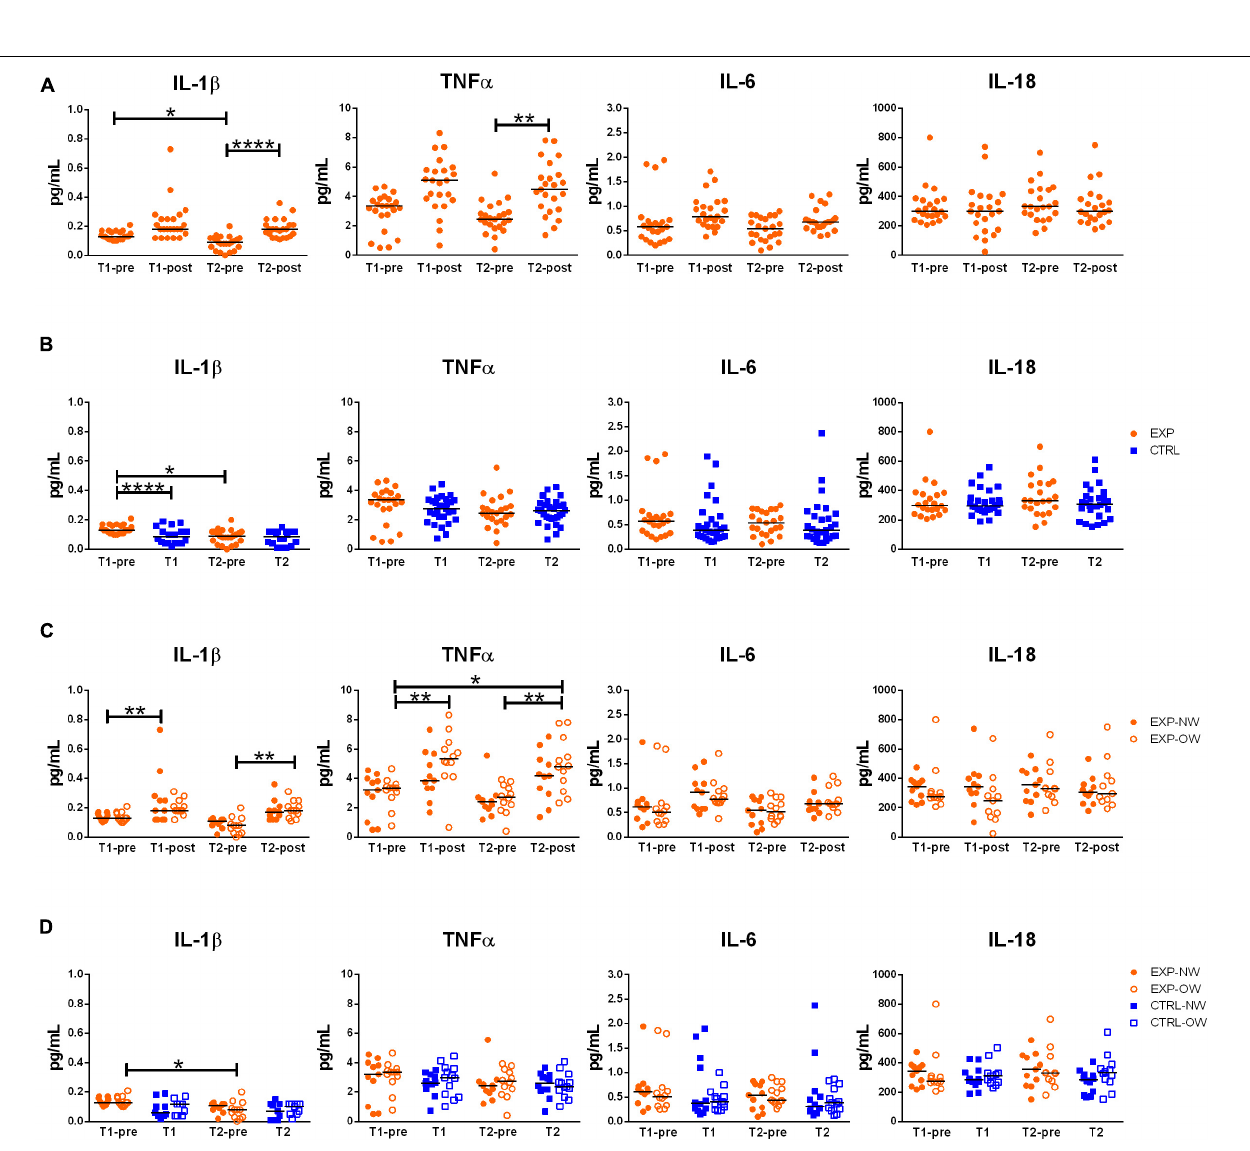
FIGURE 3 | Circulating levels of relevant cytokines associated to inflammasome pathway activation. Concentrations of IL-1 β , TNF α , IL-6 and IL-18 in sera from elderly women underwent to a 12-week aerobic Nordic walking training program (EXP, n = 29) and untrained controls (CTRL, n = 35). (A) Circulating levels of the assayed cytokines in the whole EXP group before and after the first (T1-pre and T1-post) and the last (T2-pre and T2-post) sessions of Nordic walking. (B) Circulating levels of the assayed cytokines in the whole EXP group (orange dots), before the first and the last (T1-pre and T2-pre) Nordic walking session, and in the CTRL (blue squares) over the same observation period (T1, T2). (C) Circulating levels of the assayed cytokines in the EXP cohort, grouped based on BMI in normal weight (NW, full dots) and overweight (OW, empty dots) subjects. (D) Circulating levels of the assayed cytokines in the EXP (orange dots) and CTRL (blue squares) cohorts, grouped based on BMI in normal weight (NW, full symbols) and overweight (OW, empty symbols) subjects. Asterisks indicated significant differences according to the different statistic tests applied: * p < 0.05; ** p < 0.01; **** p < 0.0001.